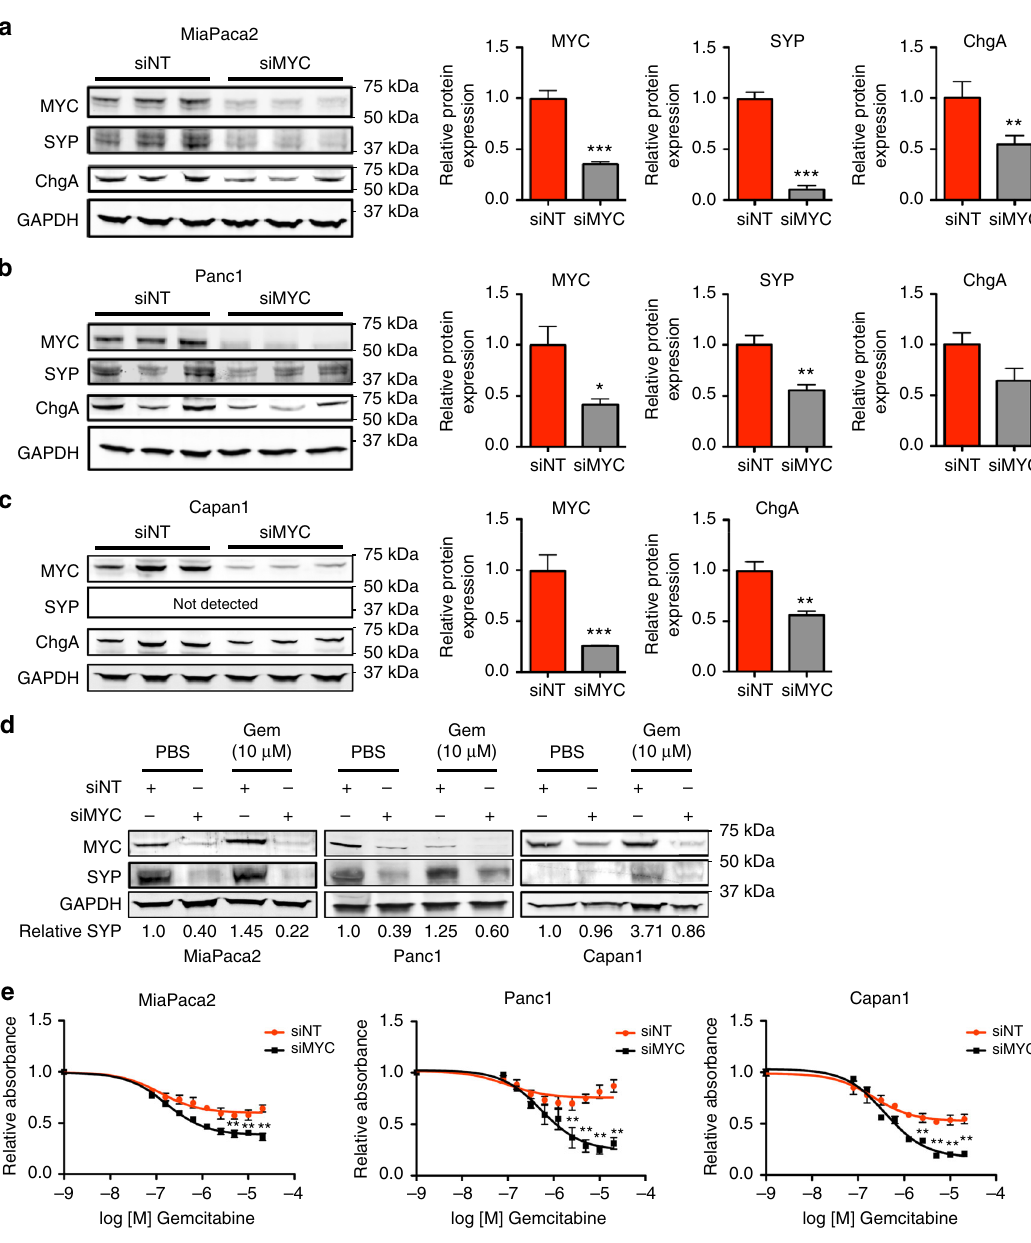
Fig. 5 MYC regulates neuroendocrine markers and gemcitabine response. a – c Loss of MYC in human PDA cell lines decreases neuroendocrine marker expression. Cells were transfected with siRNA targeting c-MYC or non-targeting control siRNA (siNT), total protein was harvested after 72 h and assessed by Western blot. Fold change in protein expression (relative to GAPDH) in siMYC cells normalized to siNT is shown for three independent experimental replicates. Error bars indicate standard deviation. * P < 0.05, ** P < 0.01, *** P < 0.001, Student ’ s two-tailed t-test. d Cells were treated with siNT or siMYC for 24 h, then treated with PBS or gemcitabine for 72 h, and assessed by Western blot. SYP protein expression (normalized to GAPDH) is shown relative to siNT PBS control. gem = gemcitabine. Error bars indicate standard deviation. e Cells were treated with siMYC or siNT for 24 h, and then treated with increasing doses of gemcitabine for 72 h. MTS assay was performed. siNT and siMYC curves are shown relative to PBS control for n = 3 experimental replicates. Error bar indicate standard deviation. * P < 0.05, ** P < 0.01, two-way